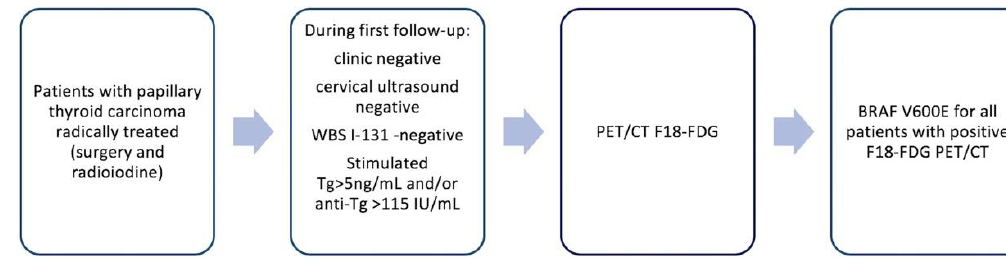
Figure 1. Diagnostic sequence for patients included in the study.